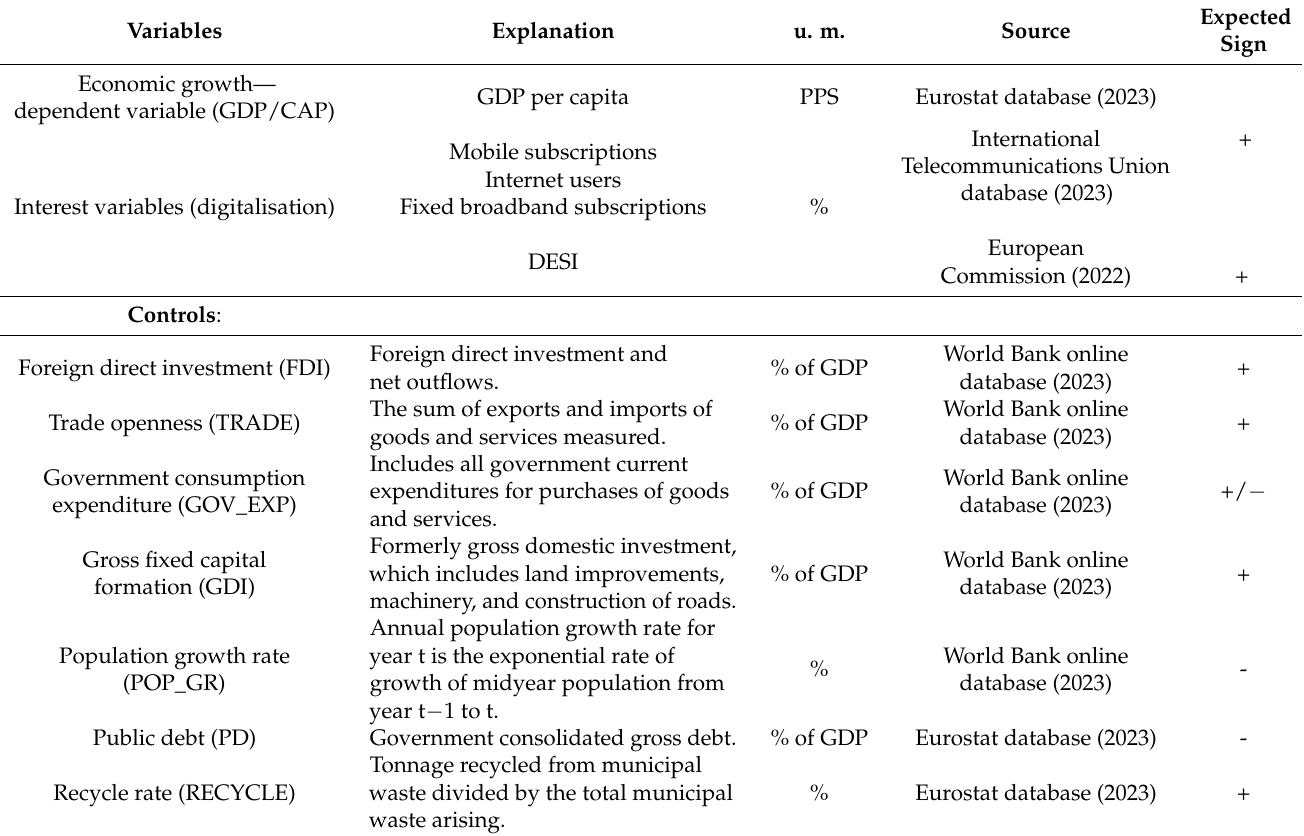
Table 3. Description of variables and their expected